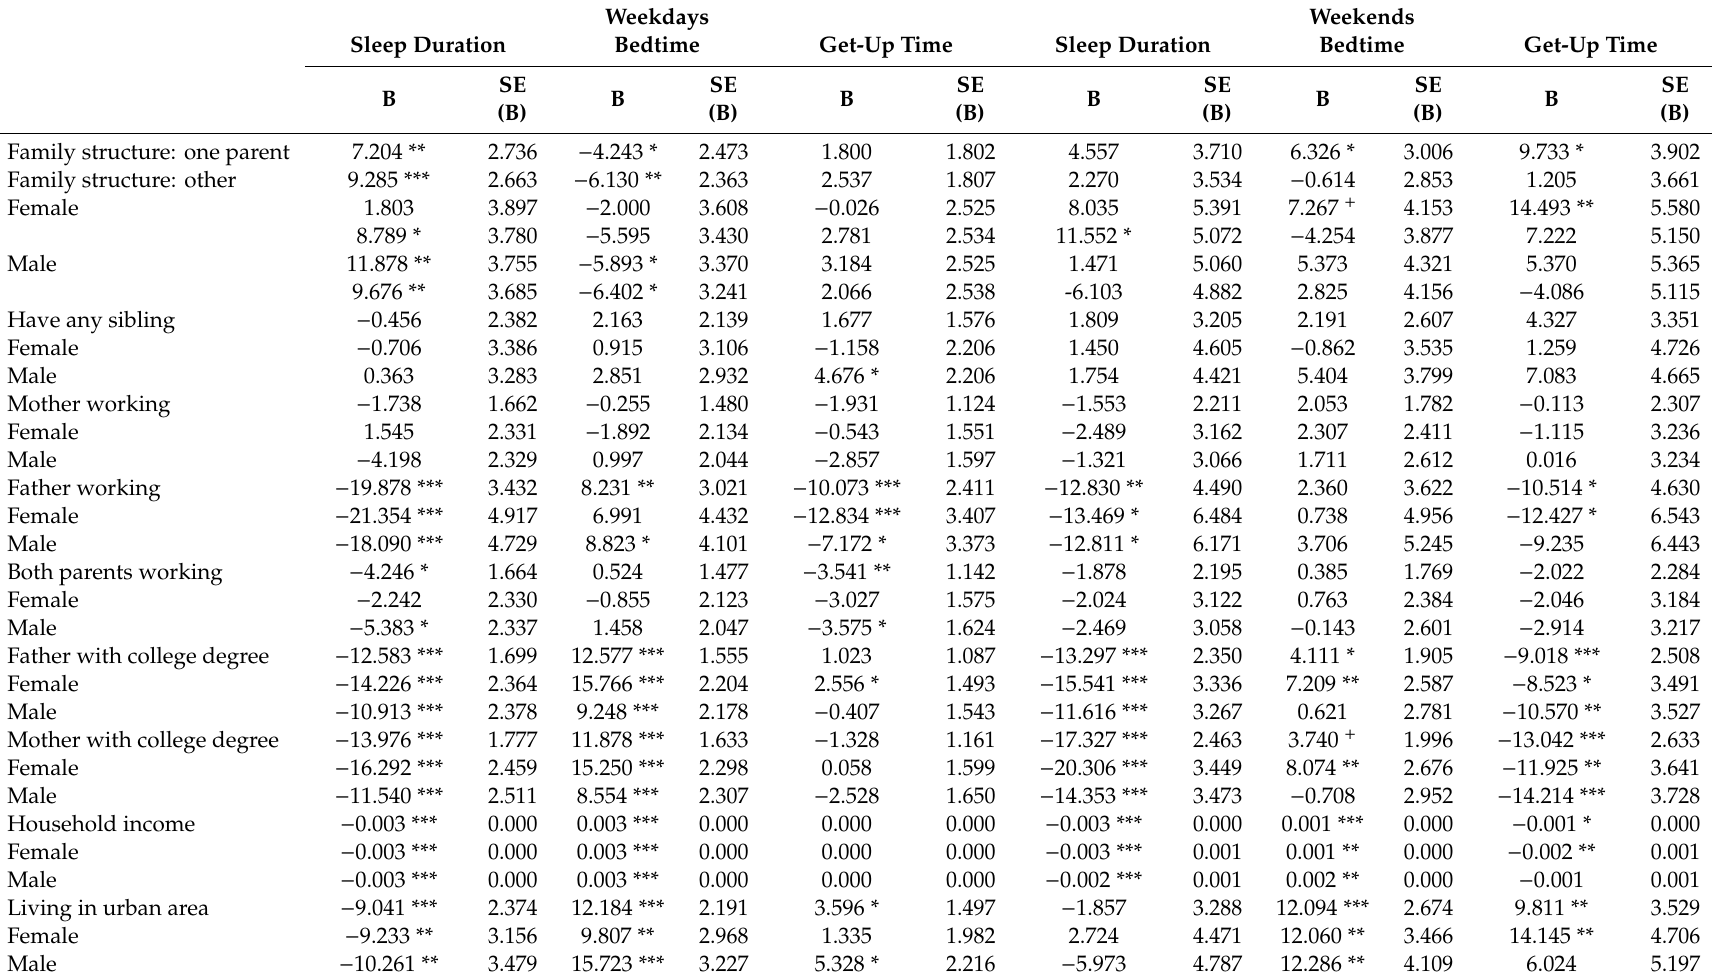
Table 2. Relationship between socioeconomic and demographic characteristics and sleep patterns of adolescent